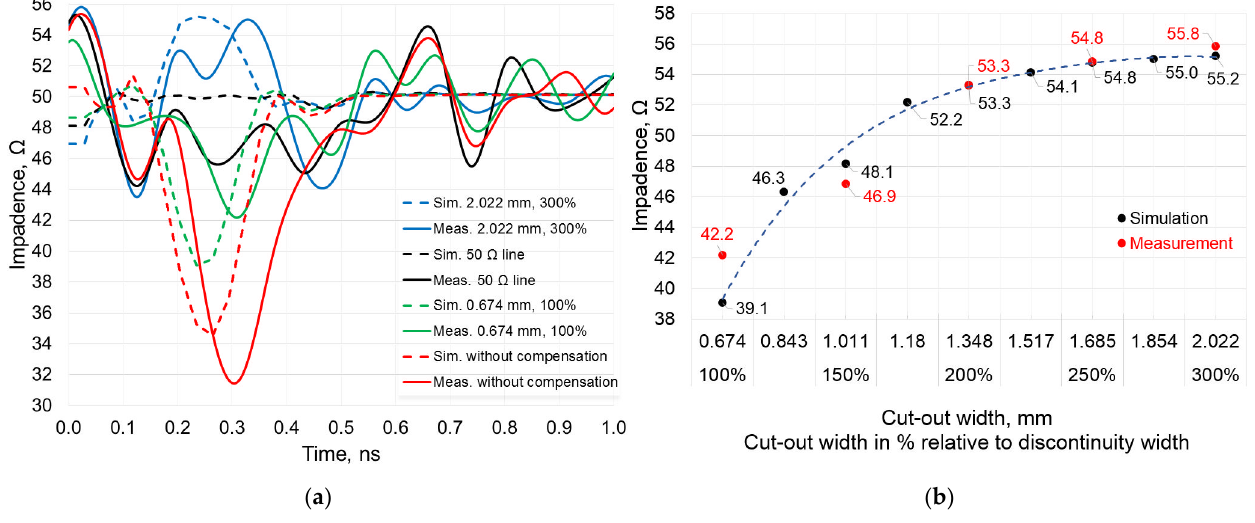
Figure 5. TDR simulation and measurement results for a track-to-discontinuity ratio of 1:1.75: ( a ) TDR response; ( b ) Impedance dependence on different cut-out sizes.